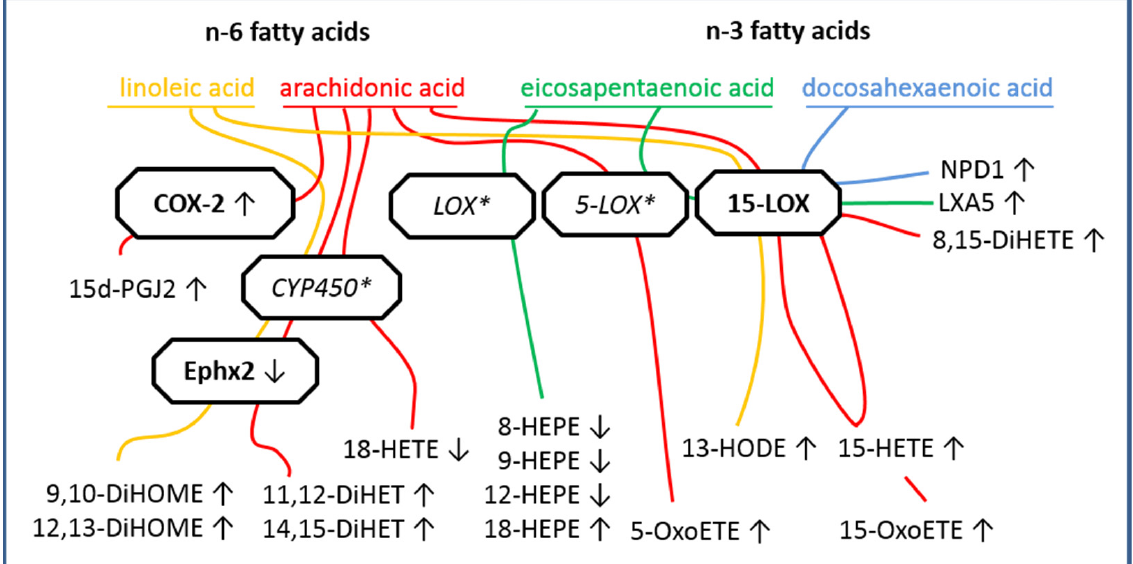
Figure 5. Summary of results and lipid mediator metabolism pathways in lipopolysaccharide (LPS)-stimulated CVO cultures: simplified pathway models of polyunsaturated fatty acids’ (PUFA) metabolism with literature-based “checkpoint” enzymes; n-6 fatty acids (linoleic acid, yellow; arachidonic acid, red) and n-3 fatty acids (eicosapentaenoic acid, green; docosahexaenoic acid, blue) are metabolized by the same enzymes: cyclooxygenases (COX), lipoxygenases (LOX), cytochrome P450 monoxygenases (CYP450), and epoxide hydrolase 2 (Ephx2). Other pathway enzymes are not displayed for better visualization. Increased or decreased levels of metabolites in supernatants or cells’ mRNA expression of enzymes are displayed by arrows (increased ↑ , decreased ↓ ). Substrates (fatty acids) and enzymes not measured by us are visualized in color (fatty acids) or in italic with an asterisk (*). Colored lines depict metabolic pathways via enzymes to produce oxylipins from their substrates. Sensory circumventricular organ (sCVO)-derived primary cell cultures were pre- incubated with PUFA (each 50 µmol/l). LPS-induced (10 µg/mL) inflammatory stimulation of cell cultures for 4 h induced mRNA expression of COX-2 and decreased mRNA expression of Ephx2. ALOX15 expression was not affected by LPS stimulation. Enzymes’ activity led to altered release of lipid metabolites into supernatants, as depicted by arrows. Arachidonic acid-derived metabolites were elevated in LPS-stimulated samples: 15-HETE (hydroxy-eicosatetraenoic acid); 8,15-DiHETE (dihydroxy-eicosatetraenoic acid), 15-OxoETE (oxo-eicosatetraenoic acid); 5-OxoETE; 11,12-DHET (dihydroxy-eicosatrienoic acid); 14,15-DHET; 15d-PGJ2 (15-Deoxy-Delta-12,14-prostaglandin-J2). The arachidonic acid metabolite 18-HETE was reduced in LPS-stimulated samples when compared to controls. Linoleic acid metabolites were increased in supernatants by LPS: 13-HODE (hydroxy- octadecadienoic acid); 9,10-DiHOME (dihydroxy-octadecenoic acid); 12,13-DiHOME. Eicosapen- taenoic acid metabolites LXA5 (Lipoxin A5) and 18-HEPE (hydroxy-eicosapentaenoic acid) were elevated in supernatants of LPS-stimulated cells, whereas 8-HEPE, 9-HEPE, and 12-HEPE levels were reduced due to LPS stimulation versus controls. Docosahexaenoic-derived NPD1 (neuroprotectin D1) was observed to be increased by LPS stimulation. Metabolic pathways are visualized according to